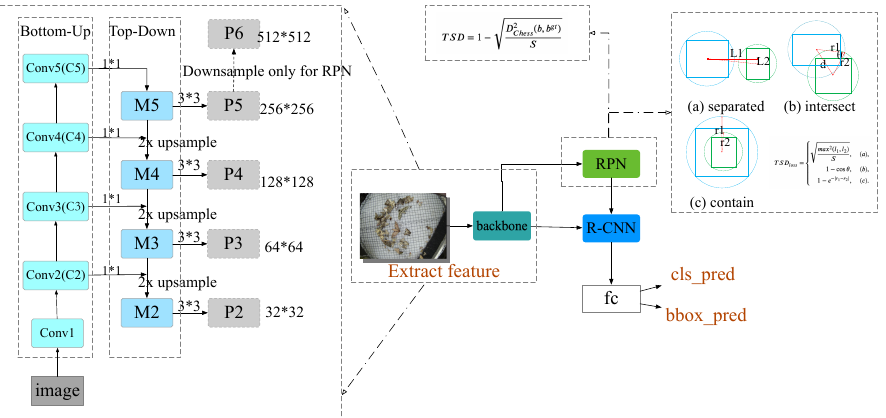
Figure 5. Network architecture. We use ResNet-50-FPN as the backbone of the two-stage network; the proposed TSD and TSD loss has been used in the